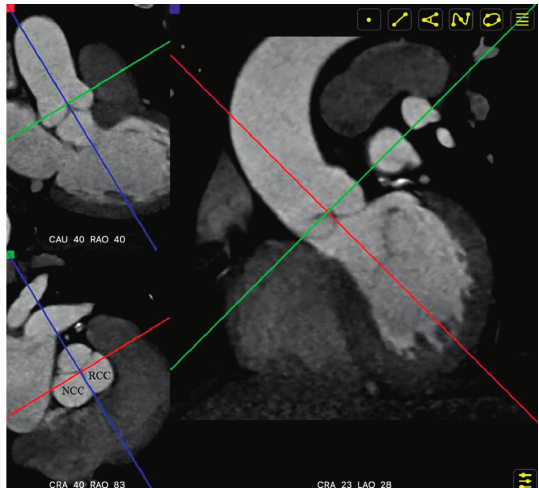
Figure 3: The blue reference line crossed the center of the cusp plane and the NCC-RCC commissure (bottom left corner). The NCC and RCC overlapped when viewed in the coronary plane. The angulation of NCC and RCC overlapping would be seen at the bottom of the coronary plane (right). NCC � noncoronary cusp; RCC � right coronary cusp. LAO � left anterior oblique; RAO � right anterior oblique; CRA � cranial; CAU �